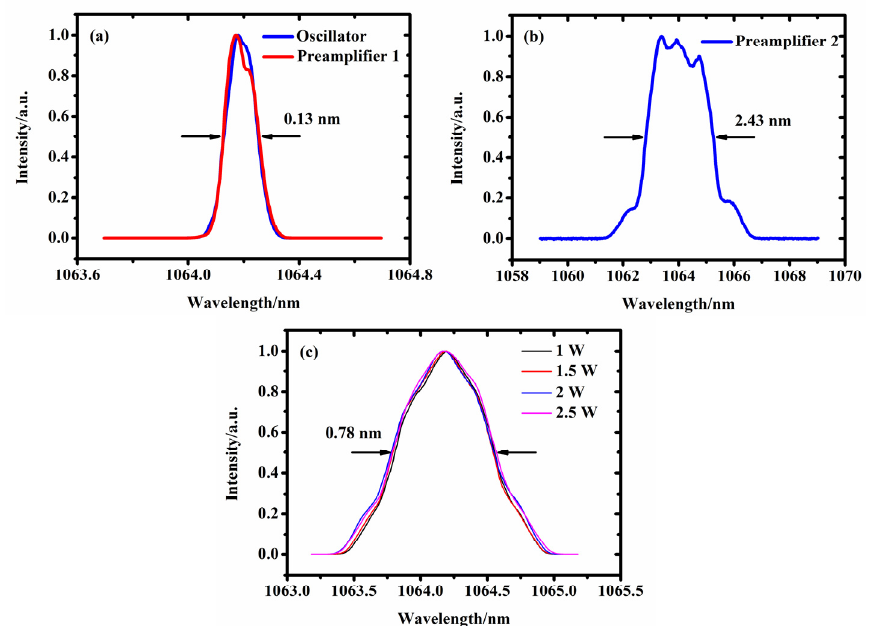
Figure 2. Spectrum distribution of ( a ) oscillator and preamplifier 1, ( b ) preamplifier 2 at pump power of 1.5 W without a pulse stretcher, and ( c ) preamplifier 2 at different pump powers with a pulse stretcher.